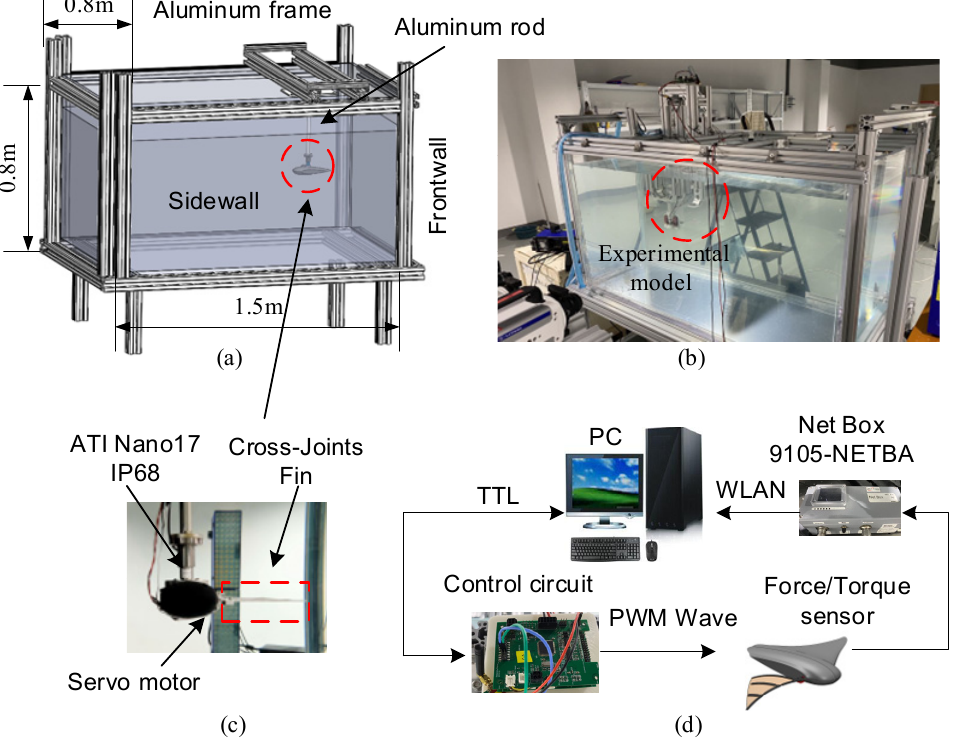
Figure 4. Experimental setup and test system ( a ) The model of the experimental water tank; ( b ) experimental water tank; ( c ) experimental model; ( d ) experimental data processing system.